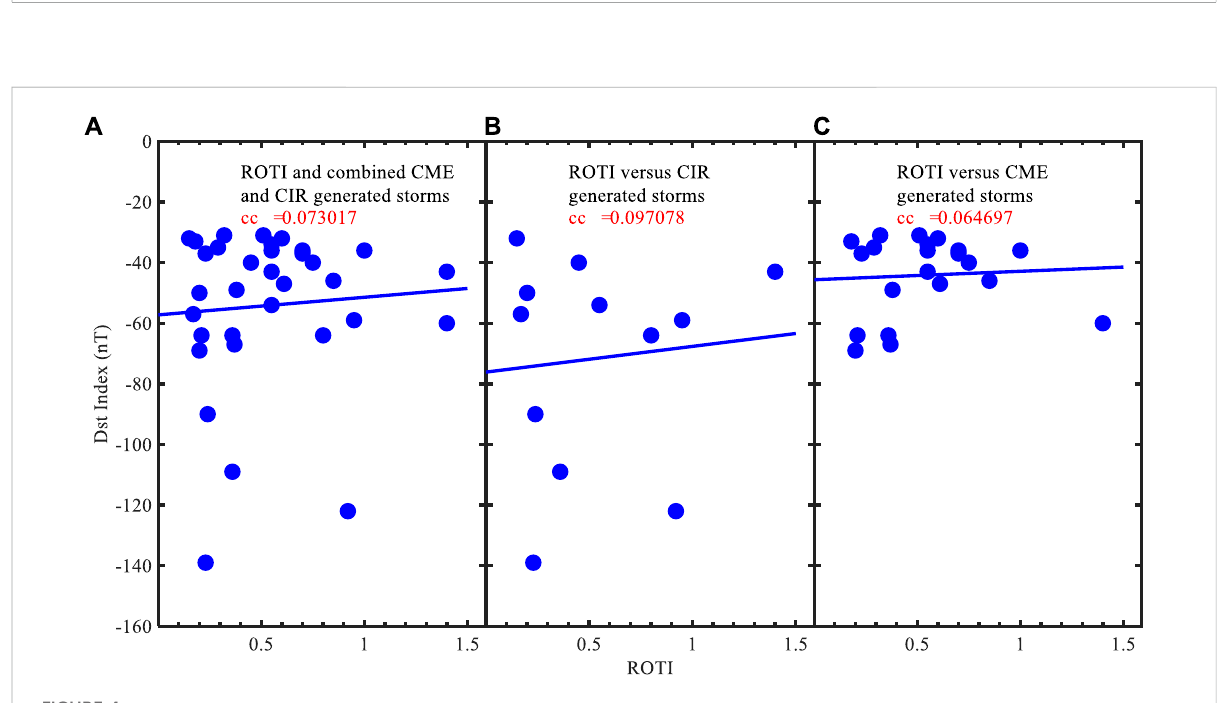
FIGURE 4 Plots of the minimum Dst against the ROTI values on the day of storm. The values, cc, on the plots represent the correlation coef fi cient of the parametersplotted.Allthestormeventswerenotassociatedwithionosphericdisturbances. (A) PlotofallDstvaluesagainsttheROTIvalues; (B) plots of the CIR-driven storms against the respective ROTI values; and (C) plots of the CME-driven storms against the respective ROTI